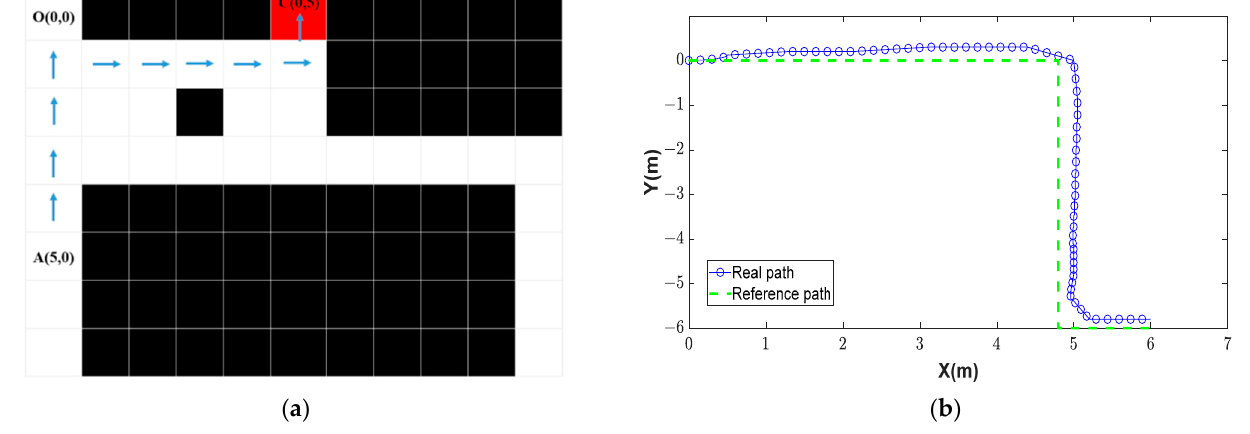
Figure 14. Representation of the simulation route using the semi ‐ automatic control and the wheelchair’s real path ( a ) The blue arrow route simulated using DQNs; ( b ) the wheelchair movement path in the real environment using DQNs and the reference path. Table 4. Wheelchair Control Commands Converted from Simulation Commands.